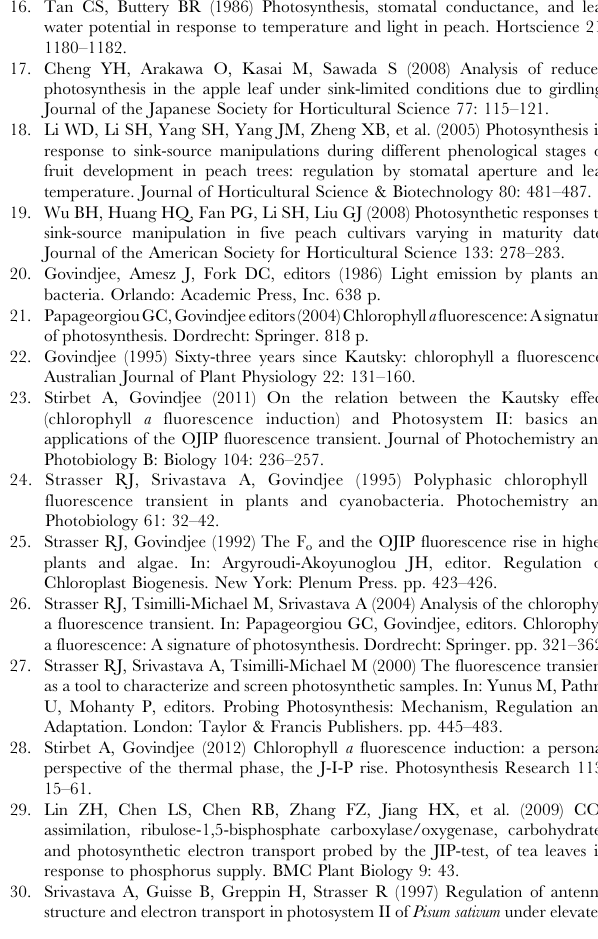
Table S1 Summary of parameters, formulae and their description using data extracted from chlorophyll a fluorescence transient